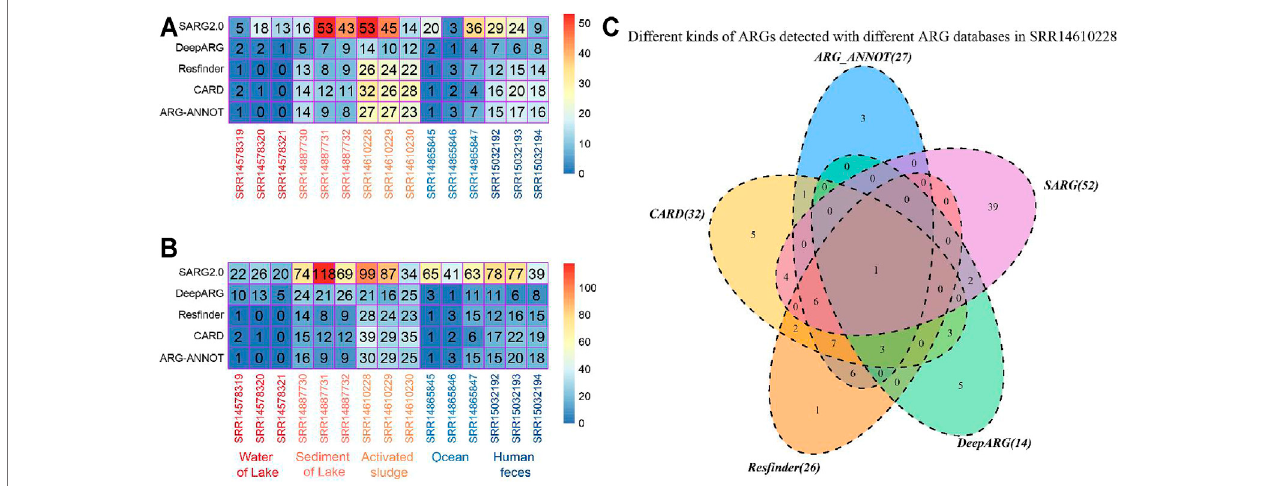
FIGURE 2 | Benchmark of the bioinformatic tools and databases for ARG detection in various environments. Distribution of (A) kinds of ARGs and (B) the total number of ARGs identi fi ed in various environmental niches with different bioinformatic tools and databases. (C) Different kinds of ARGs detected with different ARG databases in sample